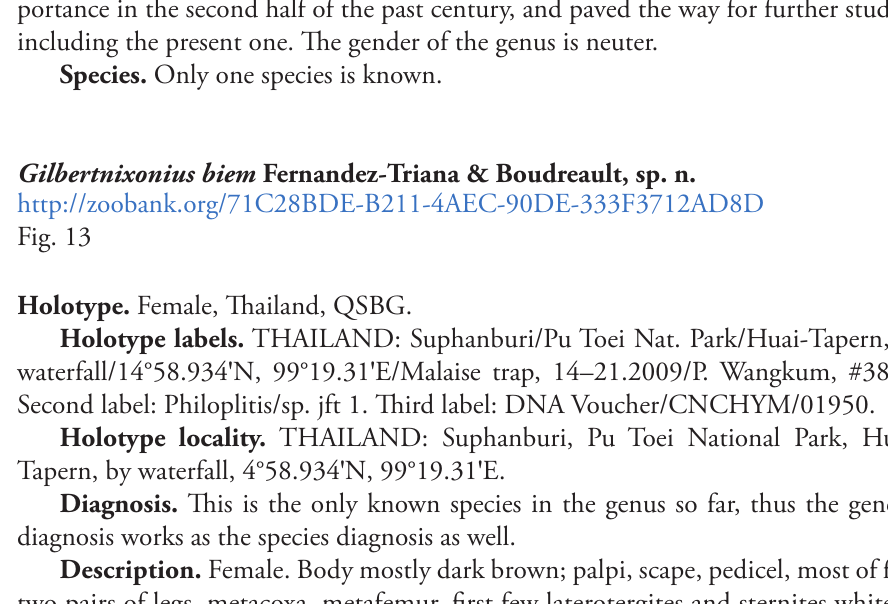
Holotype. Female, Thailand, QSBG. Holotype labels. THAILAND: Suphanburi/Pu Toei Nat. Park/Huai-Tapern, by waterfall/14°58.934 ' N, 99°19.31 ' E/Malaise trap, 14–21.2009/P. Wangkum, #3834. Second label: Philoplitis/sp. jft 1. Third label: DNA Voucher/CNCHYM/01950. Holotype locality. THAILAND: Suphanburi, Pu Toei National Park, Huai- Tapern, by waterfall, 4°58.934 ' N, 99°19.31 ' E. Diagnosis. This is the only known species in the genus so far, thus the generic diagnosis works as the species diagnosis as